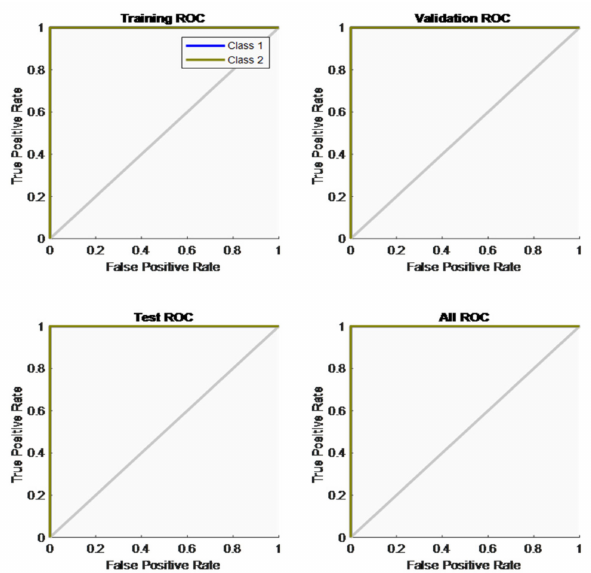
Figure 11. Confusion matrix for binary class of vegetable samples for neural network model.